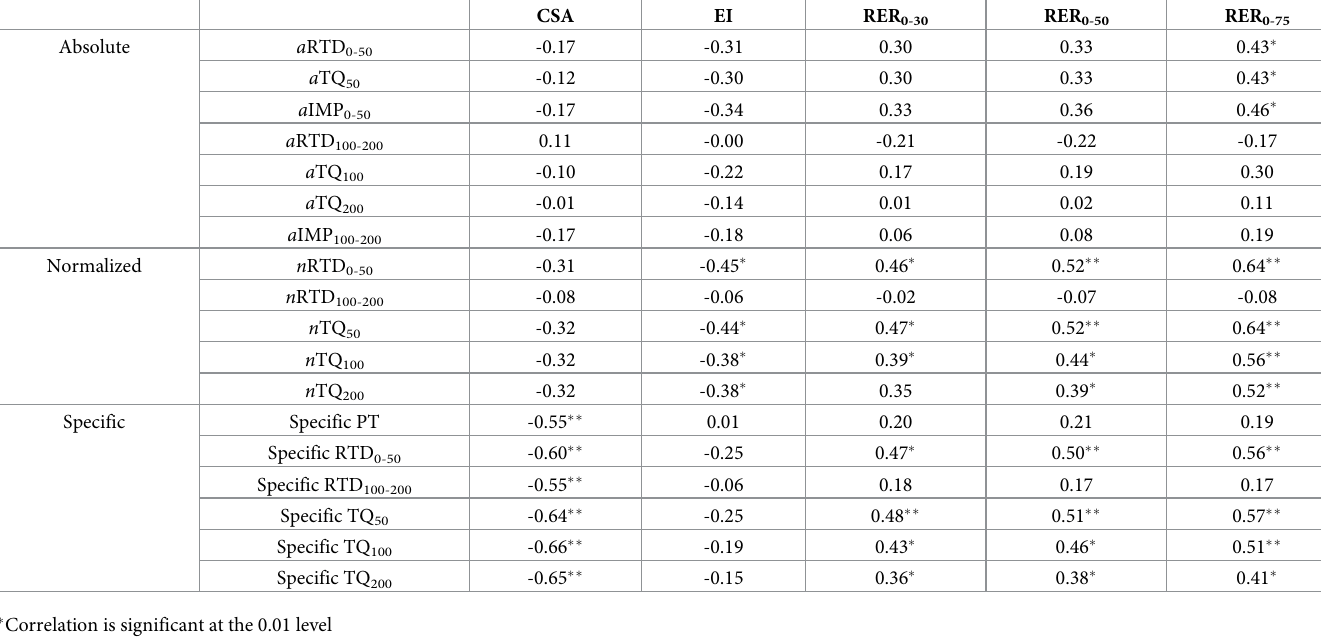
Table 4. Partial correlation coefficients between torque variables and physiological